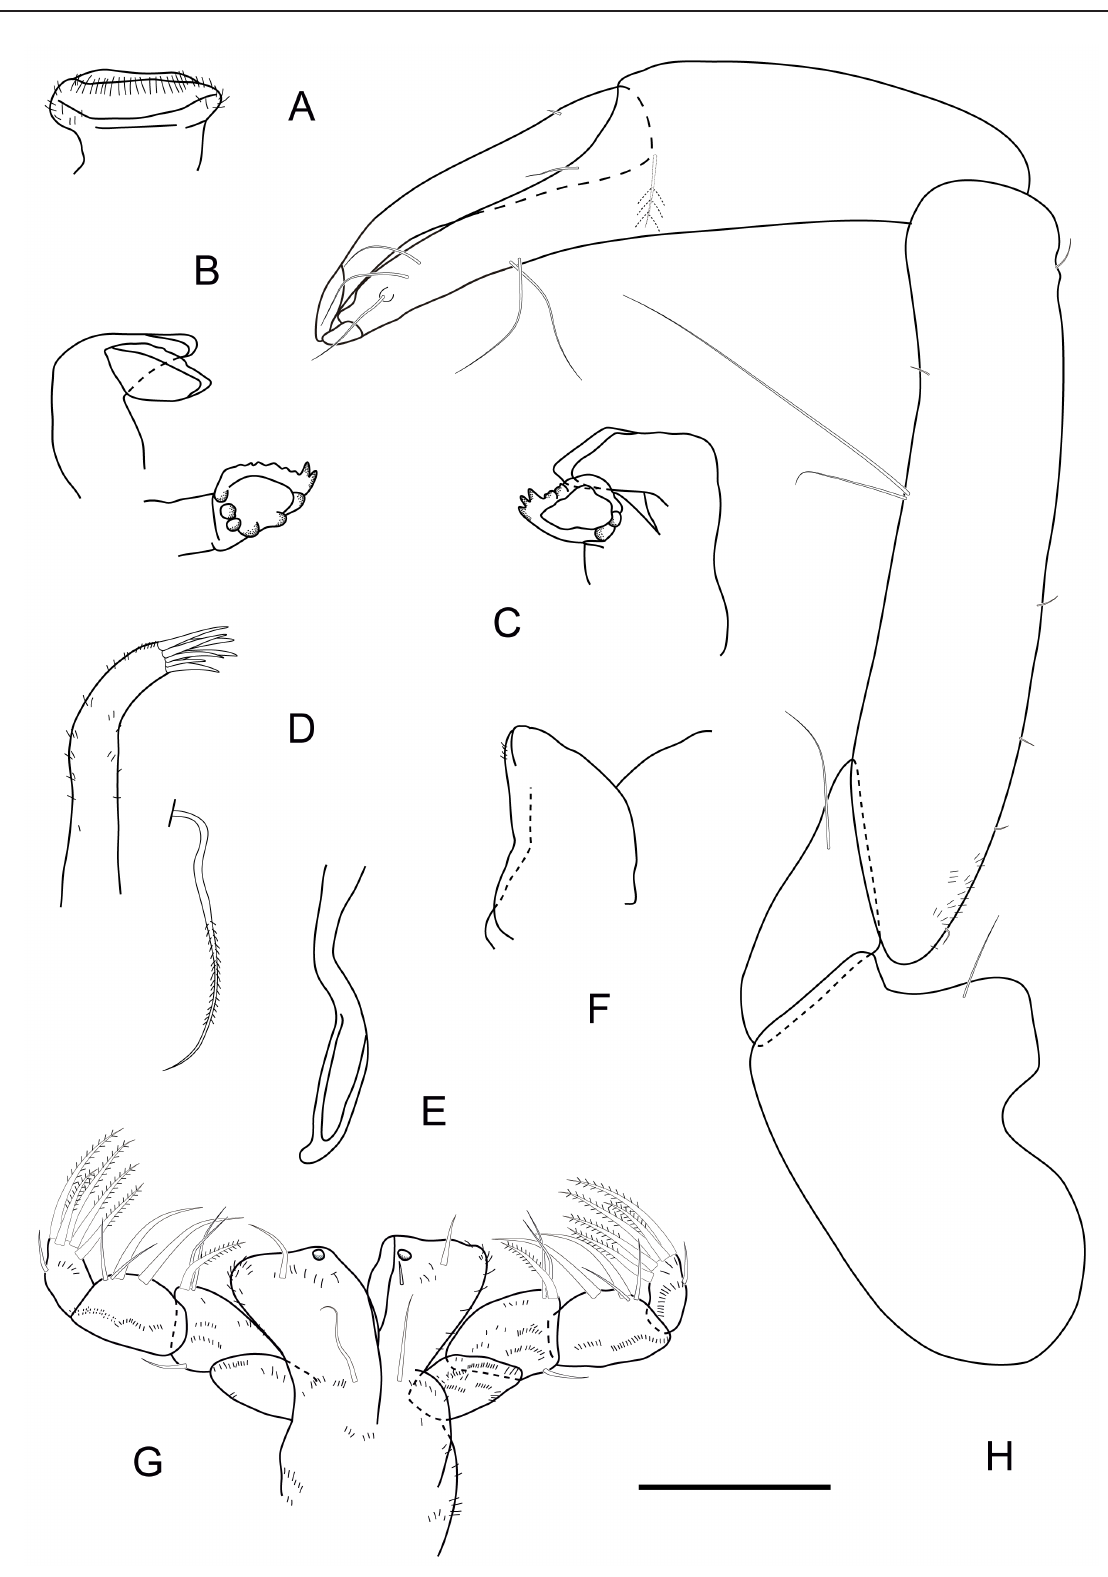
Fig. 12. Typhlotanais ischnochela sp. nov., paratype (MZUSP 34428), ♀, dissected. A . Labrum. B . Left mandible. C . Right mandible. D . Maxillule. E . Epignath. F . Labium. G . Maxilliped. H . Cheliped. Scale bar = 0.1